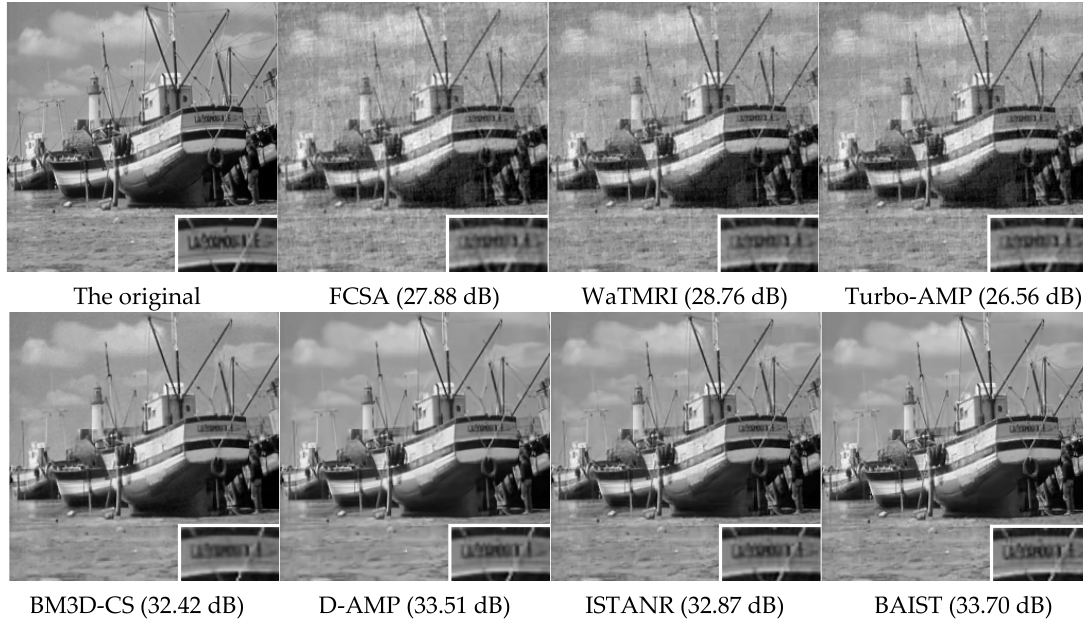
Figure 7. Visual results on boat image with 20% sampling.